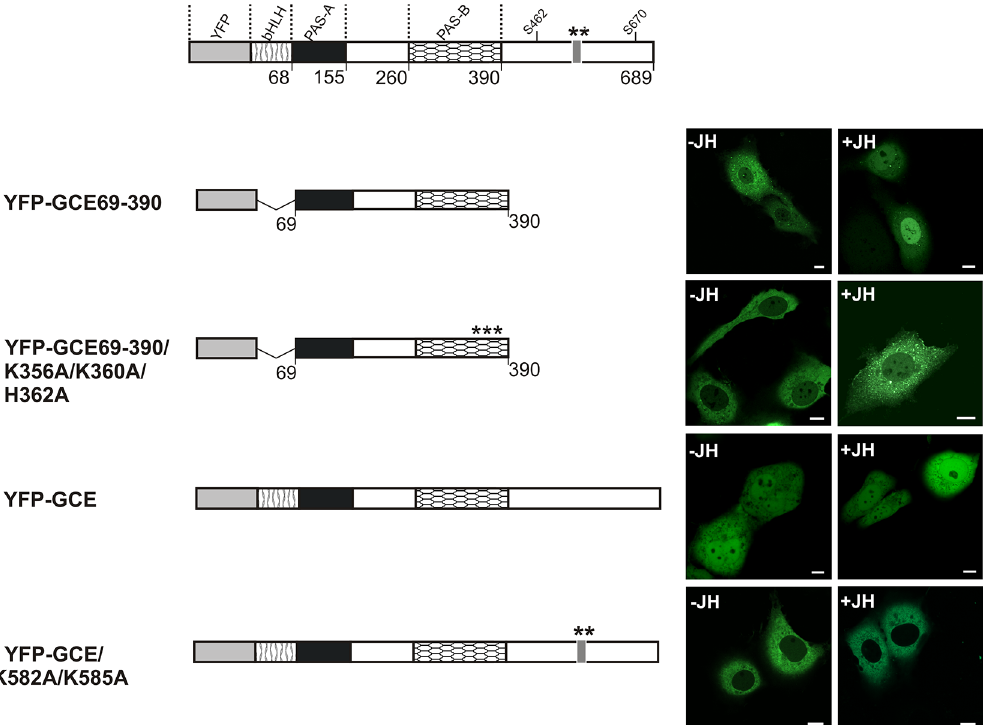
Fig 3. Subcellular localization of the NLS mutants. (A) The influence of JH on the subcellular distribution of the wild type and NLS point mutants of the bHLH-PAS-B area and full length GCE in COS-7 cells was analyzed. The subcellular localization of the expressed proteins tagged with YFP was analyzed by confocal microscopy 20-24h after the transfection of COS-7 cells in the absence or presence of JH. The length of each domain in protein schematic illustration is arbitrary. Regions of GCE are depicted using different patterns. Asterisks indicate mutated residues. Representative images (single confocal plane) present the typical subcellular distribution of the GCE derivatives. Bar, 10 μ m. (B) ClustalX alignment of the MET588-631/GCE414-457 encompassing putative NES in C-terminal fragment of